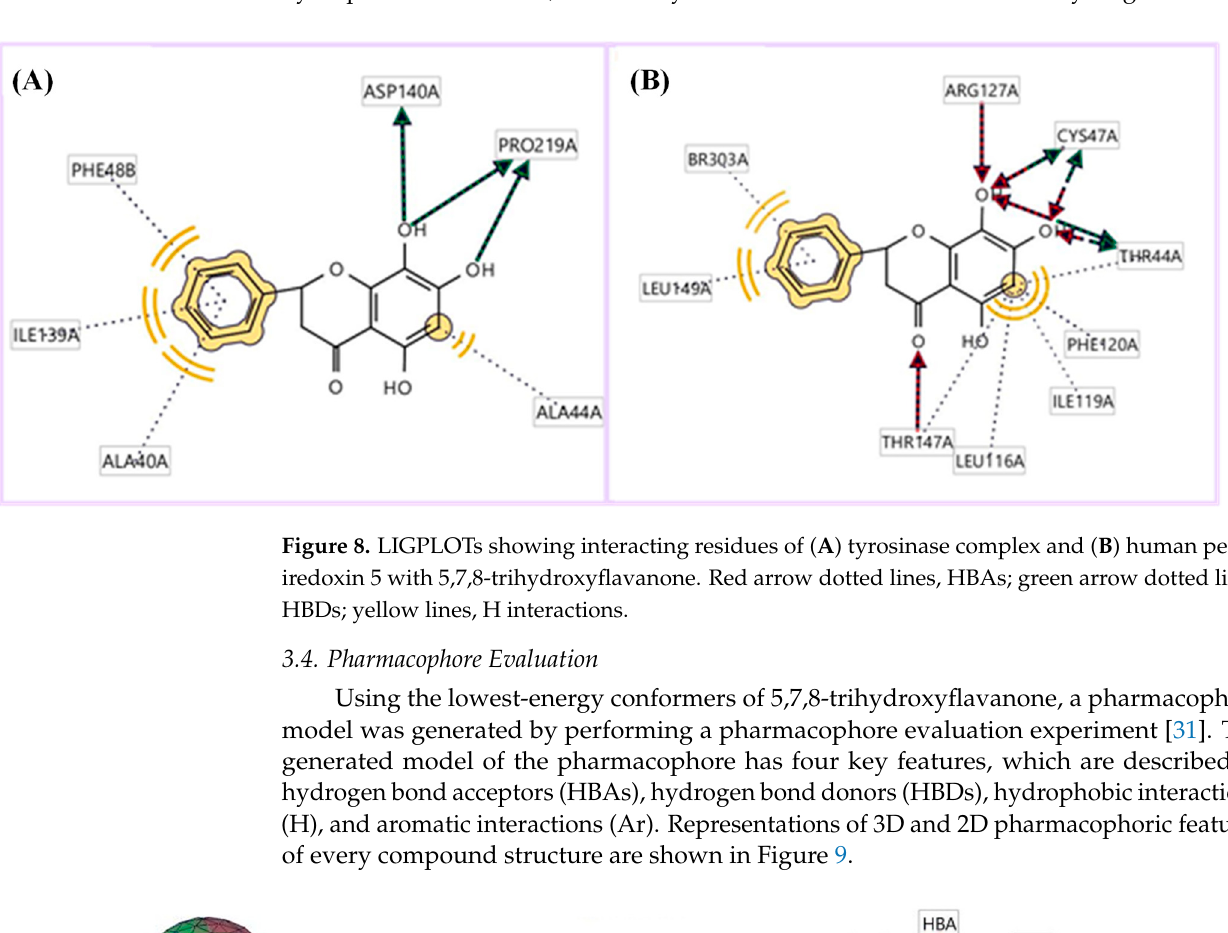
14 of 18 Figure 7. ( A ) Binding site (yellow color) of tyrosinase from Bacillus megaterium ; ( B ) binding site (yel- low color) of human peroxiredoxin 5. Table 2. Docking analysis of the five major metabolites from cupuassu ( T. grandiflorum ) on different protein receptors with respect to quercetin; Compound Docking Score (kcal/mol) PDB:3nm8 ( Bacterial tyrosinase) Docking Score (kcal/mol) PDB: 1HD2 (Human Peroxiredoxin 5) Quercetin (standard)